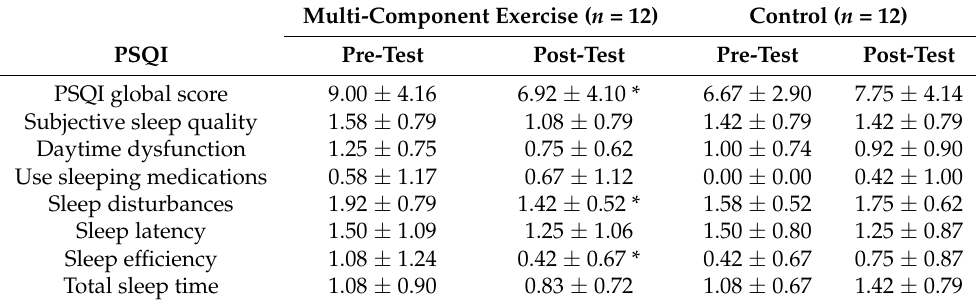
Figure 1. Changes in the Pittsburgh Sleep Quality Index (PSQI) scores over time between multi- component exercise (exercise) and control groups: ( a ) PSQI global score; ( b ) sleep disturbances; ( c ) sleep efficiency. * Significant difference between the pre-test and the post-test. Note. Data are presented as standard errors of mean. Table 2. Changes in the Pittsburgh Sleep Quality Index (PSQI) scores over